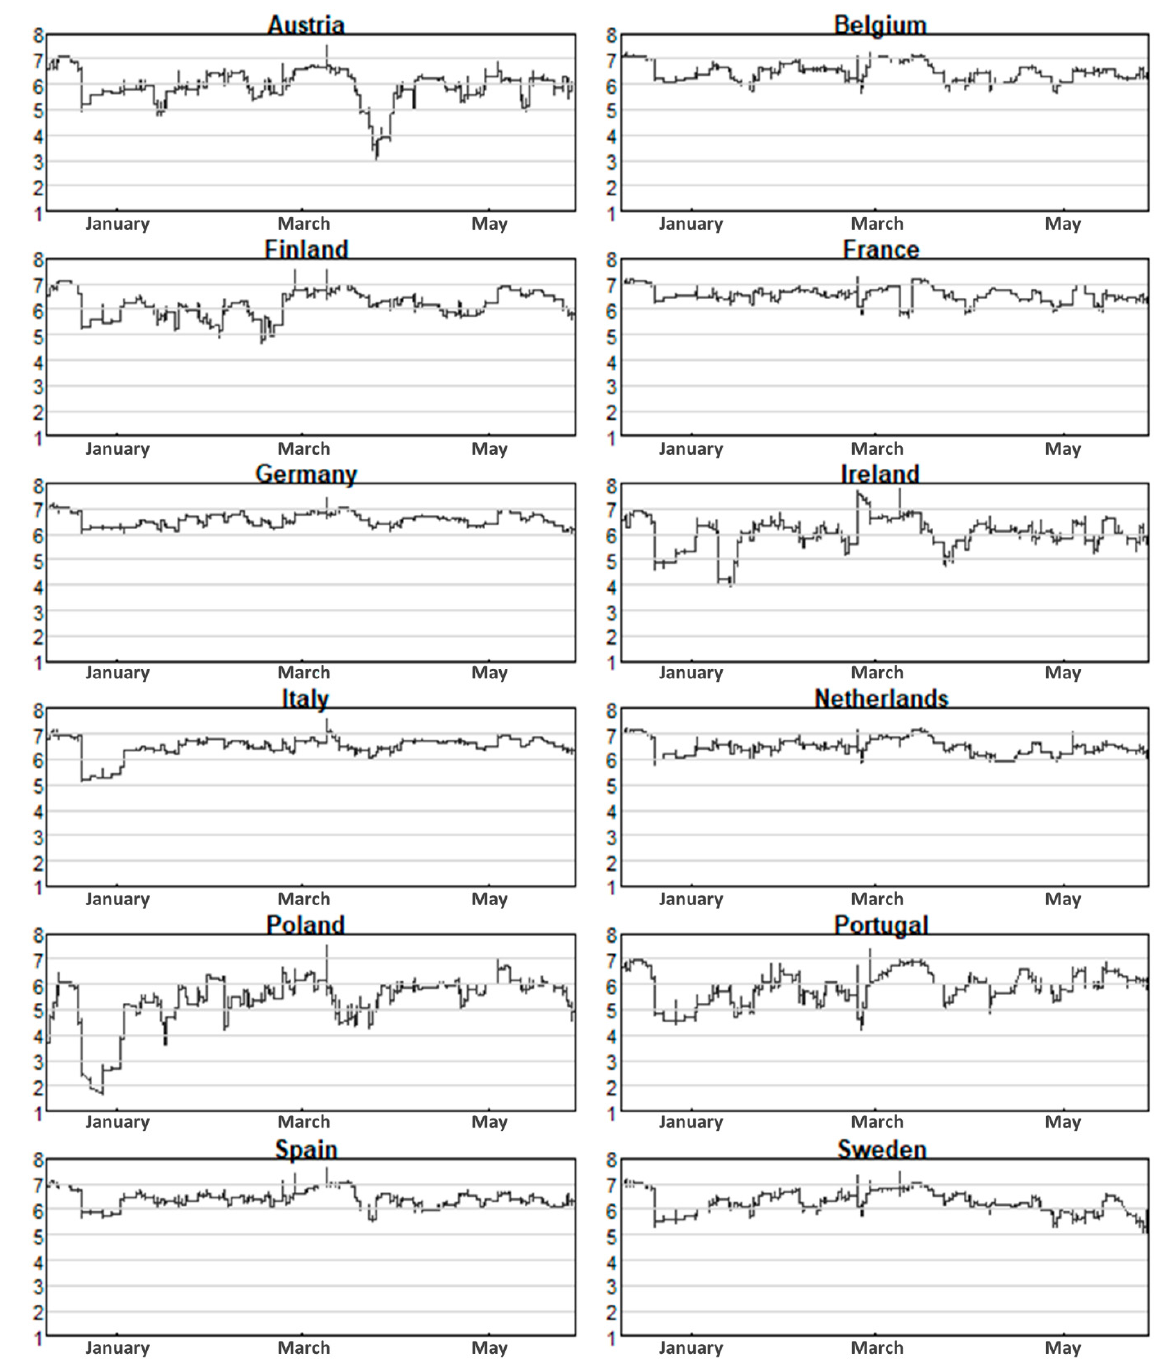
Figure 2. Intraday Directional volatility spillovers, FROM all Stock Markets during COVID-19.